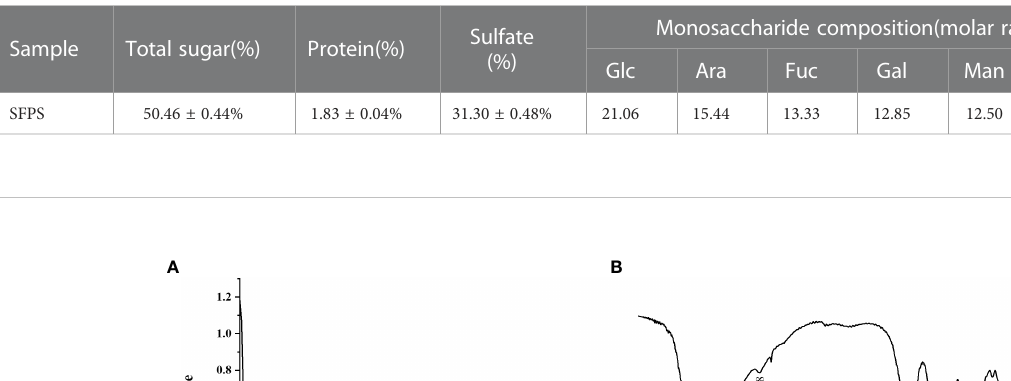
TABLE 1 Chemical composition of SFPS.